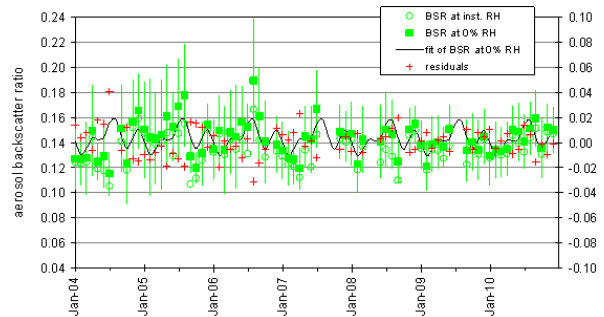
Figure 6. Variations in the aerosol single scattering albedo at 550nm at IPR: monthly mean values at instrumental RH (open cir- cles), at 0% RH (squares), least mean square fit of the monthly mean values at 0% RH (line), and residuals (crosses, right axis). Error bars show the standard deviation of the monthly mean values at 0%